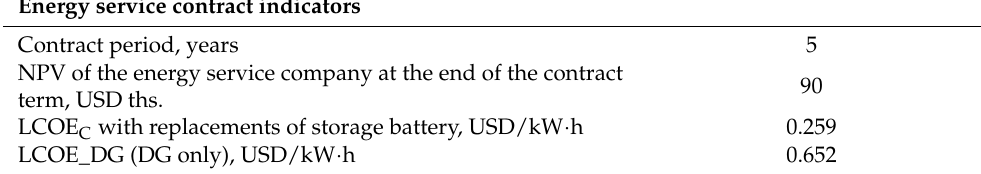
Table 1. Cont. Energy service contract